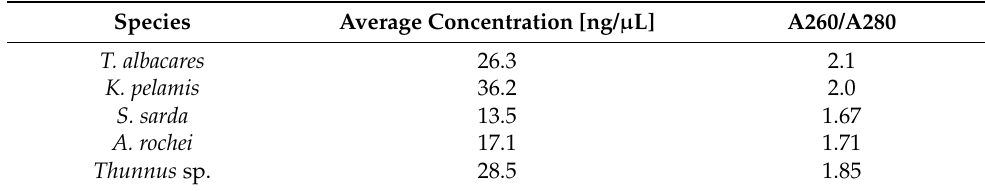
Table 1. Determination of DNA concentration and purity in selected